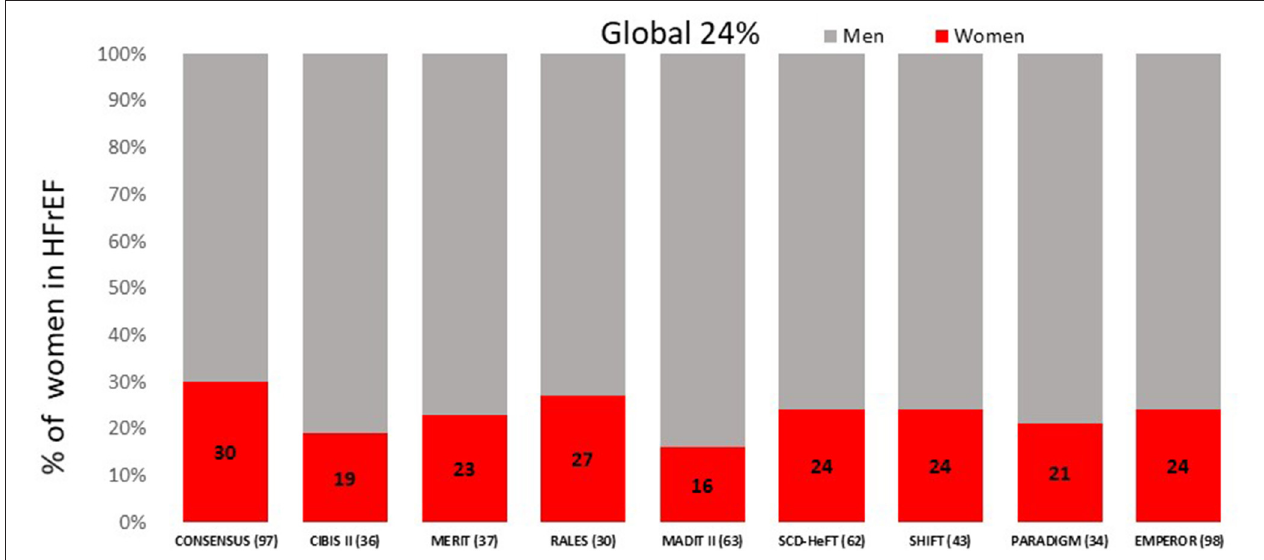
FIGURE 1 | Proportion of women included in the major HFrEF clinical trials. HFrEF, Heart Failure reduced Ejection Fraction.